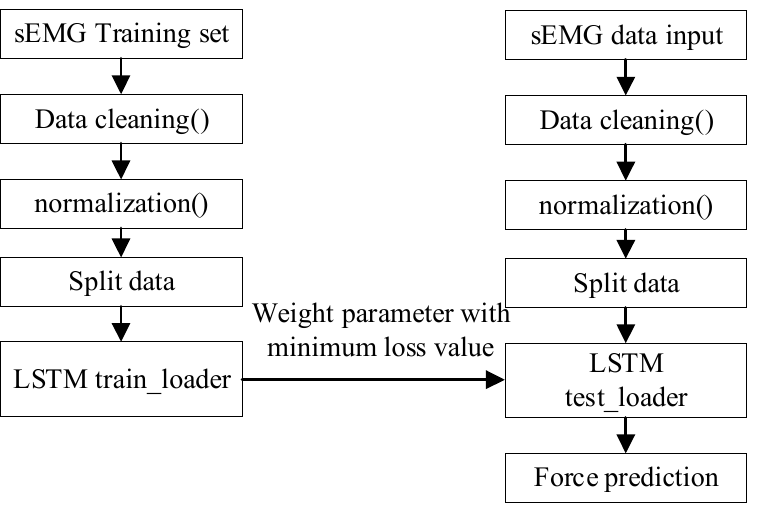
Figure 12. Force prediction using LSTM.